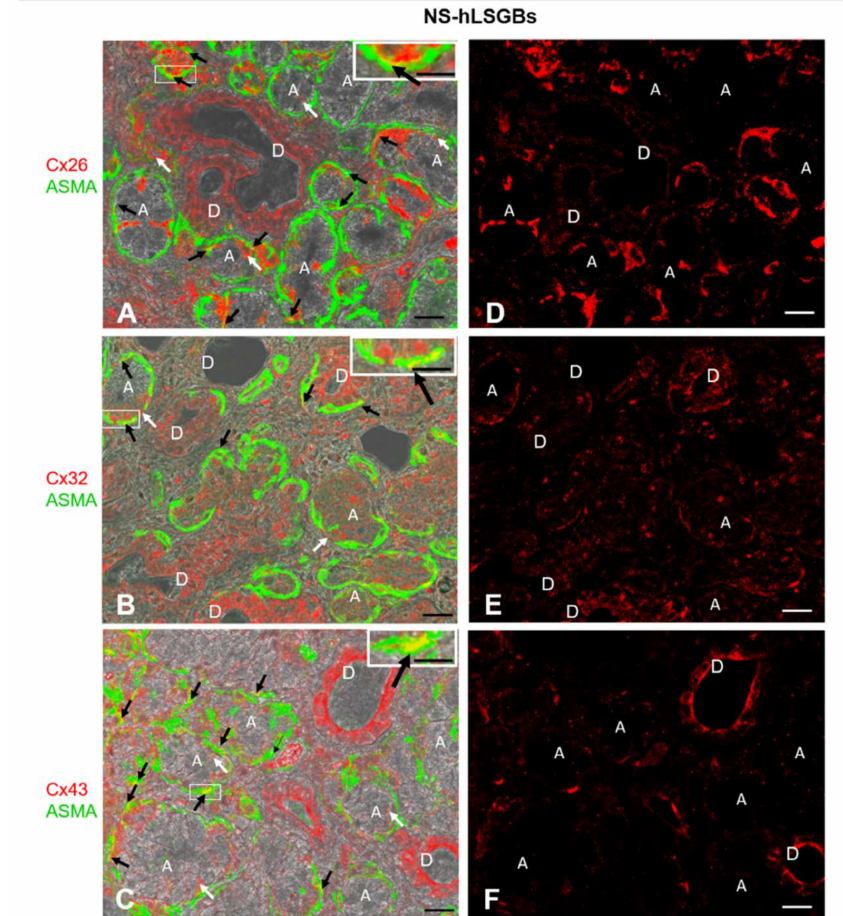
Figure 1. IF analysis for Cx26, Cx32, and Cx43 in NS-hLSGBs. ( A – C ) Representative confocal microscopy images of double IF with transmitted light contrast. Merged images show Cx positivity in red, ASMA positivity in green, and Cx-ASMA colocalization in yellow. These images have been modified by enhancing the saturation in order to better appreciate the yellow stain. White arrows indicate red immunoreaction at the plasma membrane of the duct cells and at the basal/basolateral side of the acinar cells. Black arrows point to the yellow spot due to the colocalization of Cx and ASMA. Inserts show the higher magnification of the squares. ( D – F ) Single IF images representing Cx immunoreactions (red) corresponding to ( A – C ) microscopic fields. A, acinus; D, duct. Scale bars, 20 µ m; Inserts, 10 µ